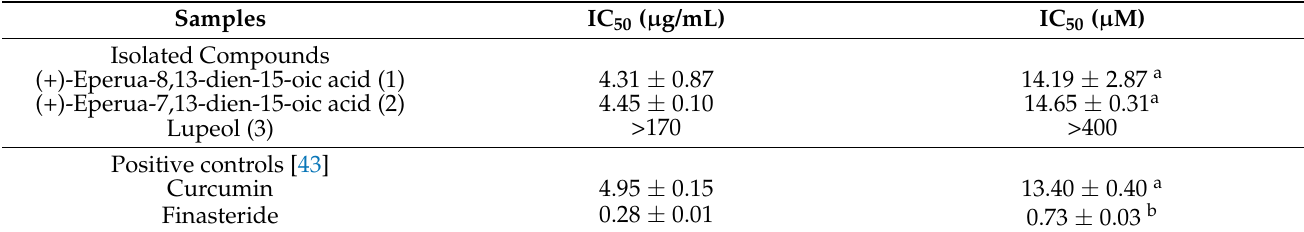
Table 1. IC 50 values against 5 α -reductase of the three isolated compounds ( 1–3 ) and two 5 α -reductase inhibitors. The data are expressed as the means ± standard deviation (SD) of triplicate